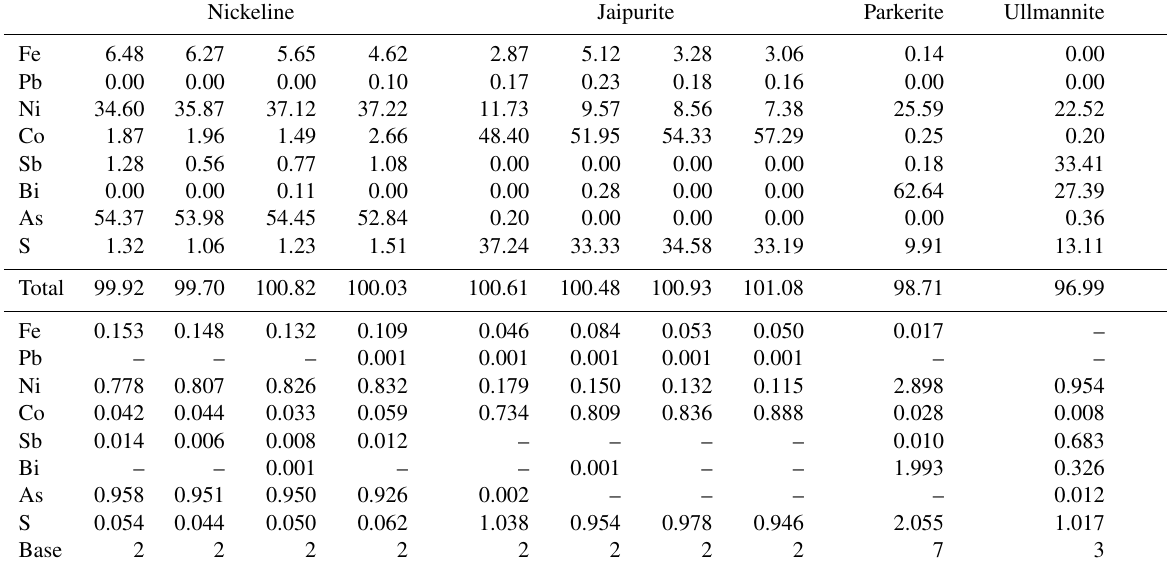
Table 10. Representative analyses (wt%) for nickeline, jaipurite, parkerite and ullmannite from Pˇríbram. Nickeline Jaipurite Parkerite Ullmannite